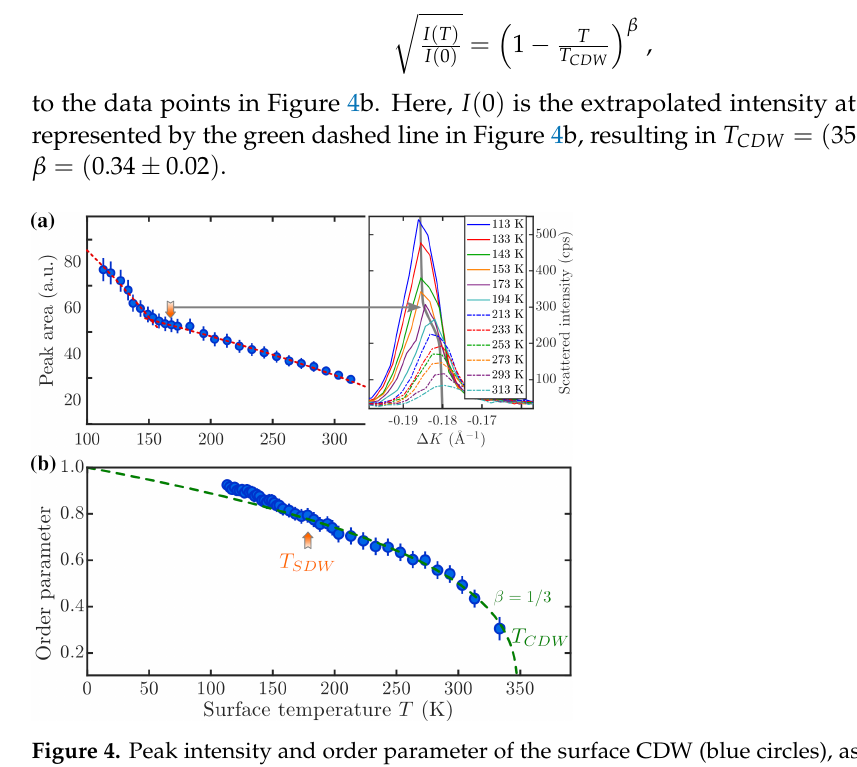
Figure 4. Peak intensity and order parameter of the surface CDW (blue circles), as extracted from the temperature dependence of the − g CDW CDW peak in Figure 3b (see text). The right panel in ( a ) shows several scans, illustrating a rapid shift in the satellite peak, occurring at around 180K, from − 1 − 1 a momentum transfer of 0.18Å to 0.186Å . Together with the corresponding deviation of the order-parameter fit below about 180K ( T SDW ) in ( b ) and the time-reversal symmetry break (missing + g CDW peak at low T in Figure 3b), it suggests the onset of a spin ordering (a spin-density wave), which allows, through the Rashba effect, for a parallel momentum transfer only in one direction. ( b ) The fit of the order parameter with the fluctuation critical exponent β = 1/3 [66] (green dashed line) yields a critical temperature T CDW of about 350K. The red dashed line in ( a ) illustrates separate fits to the peak intensity in the two temperature regimes with two critical temperatures T SDW and T CDW ,